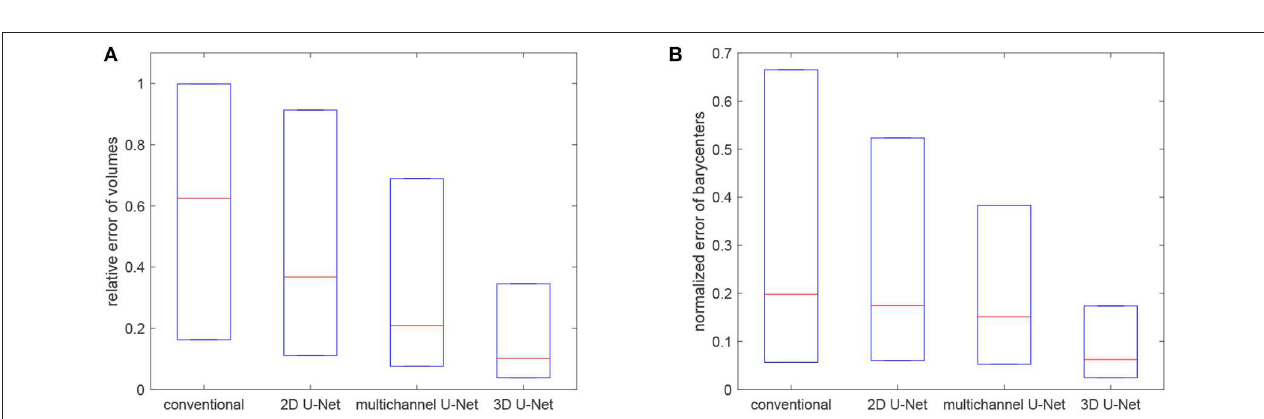
FIGURE 11 | Boxplots visualizing the quartiles of errors of volumes (A) and barycenters (B) for the considered segmentation techniques.